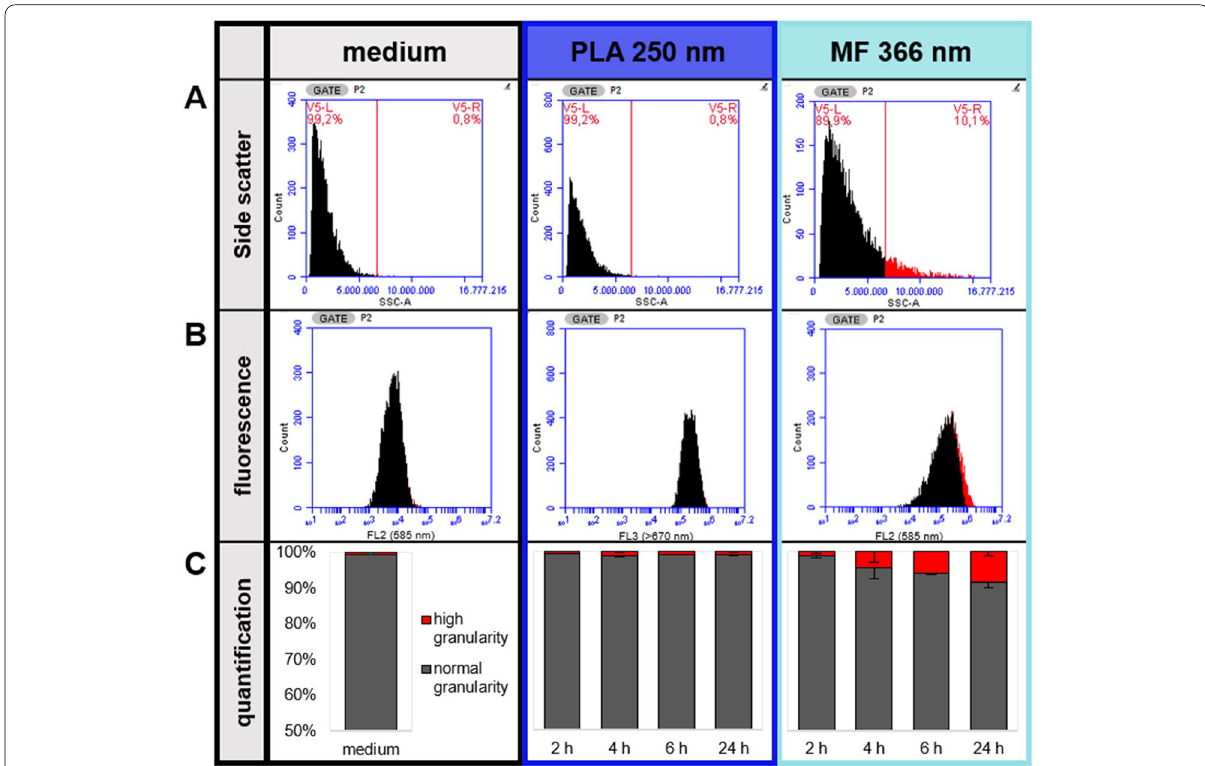
Fig. 6 Side scatter analysis of PLA250 and MF366 after 2, 4, 6 and 24 h incubation with HepG2 cells. A Representative Histograms of signals detected by the side scatter after 24 h incubation. The vertical red line shows the threshold between normal cell granularity and increased granularity due to particle uptake (red). B Representative Histograms of measured fluorescence signal correlating to ( A ). Red labeled counts show cells with high side scatter. C Quantification of the increase of the side scatter after 2, 4, 6 and 24 h incubation. Cells with high granularity are depicted in red and cells with normal granularity in gray. Data are shown as means